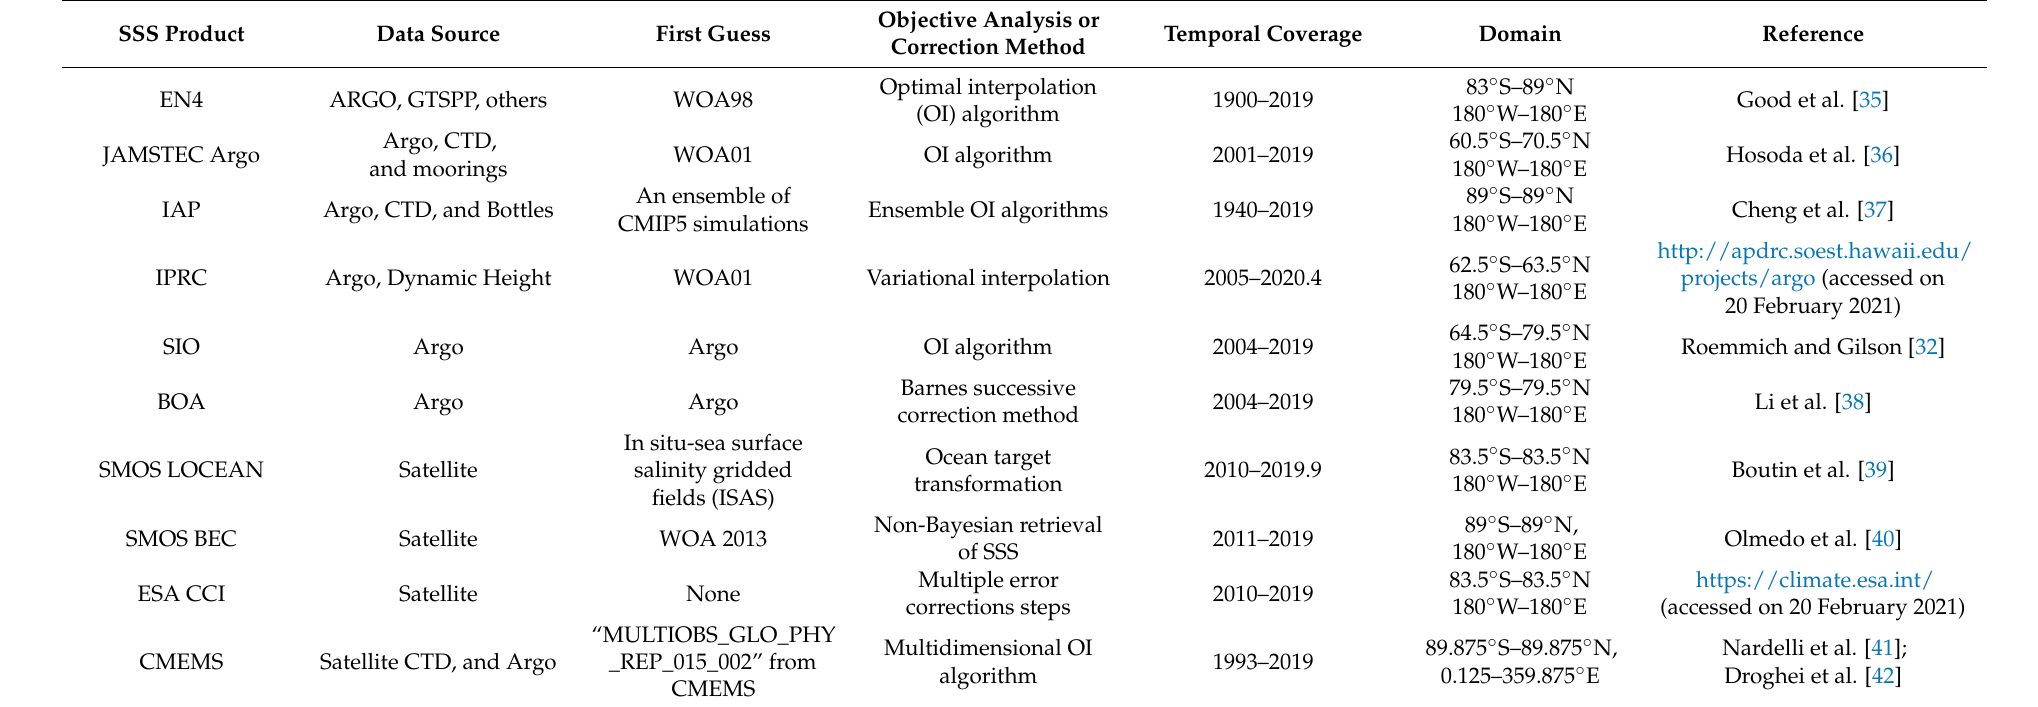
Table 1. Characteristics of the ten products used in this